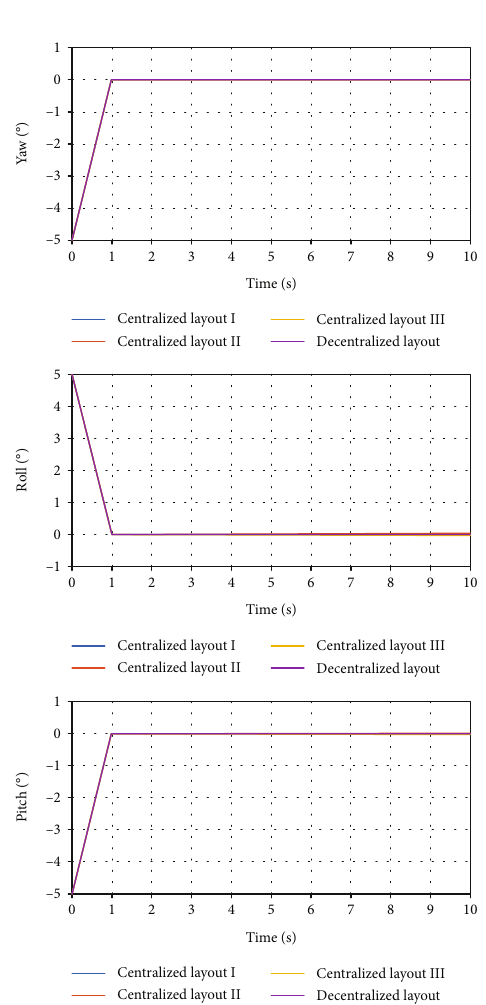
Figure 11: Estimation error of Euler angles (initial